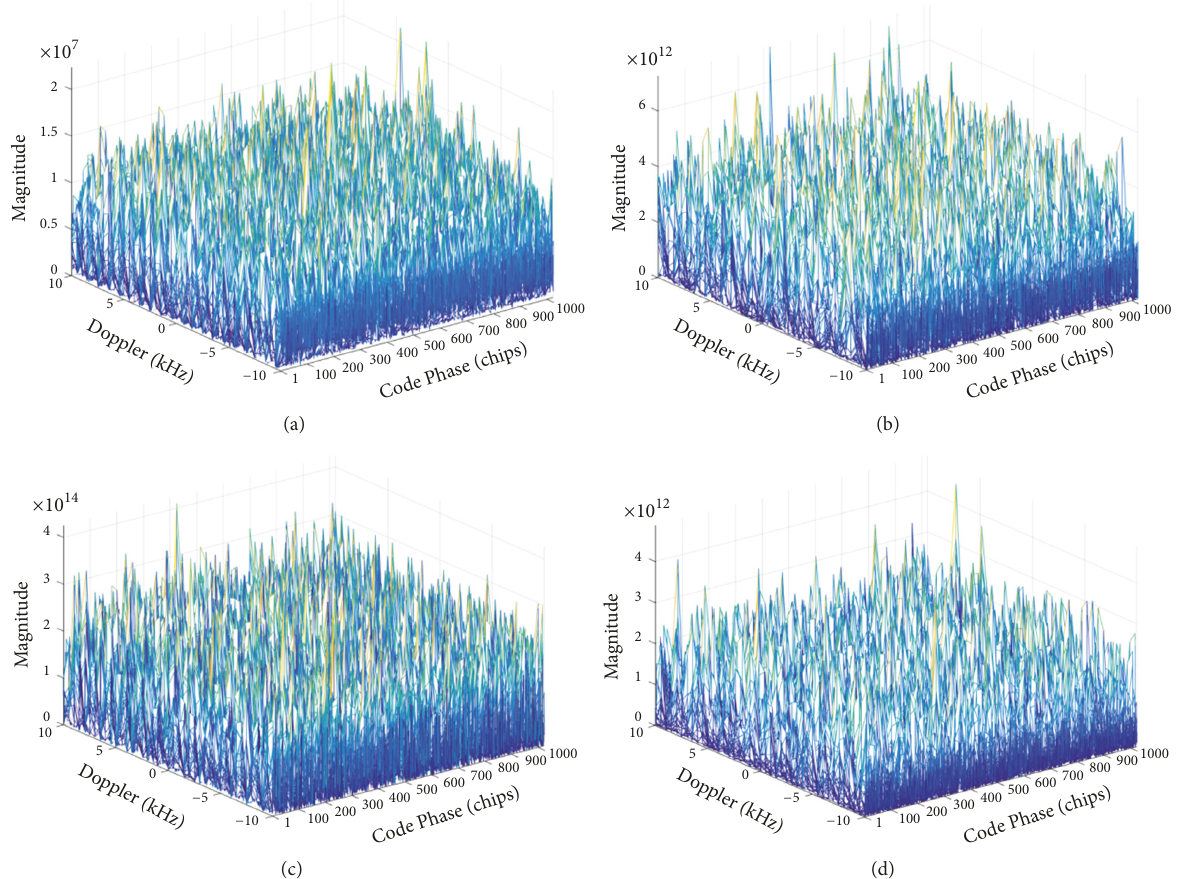
Figure 4: Acquisition results in the impulsive noises with traditional adaptive beamformers in GNSS receiver: (a) CLMS-L1; (b) MRVSS; (c) CLMS; (d) LMS.